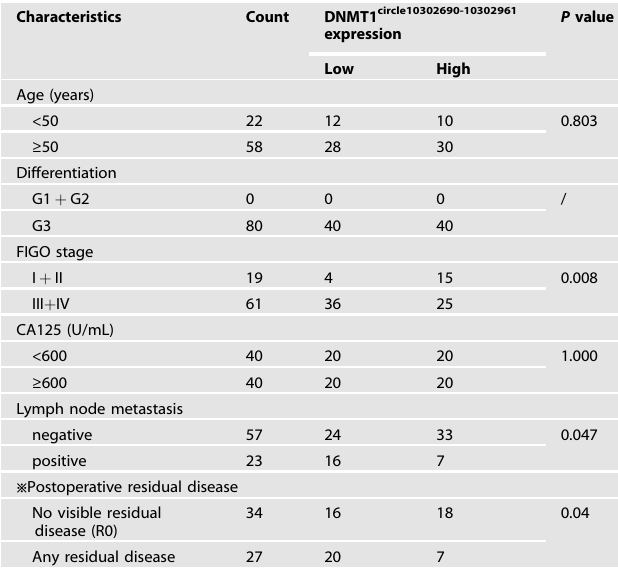
Table 1. The correlation between DNMT1 circle10302690-10302961 expression and clinicopathological characteristics in HGSOC